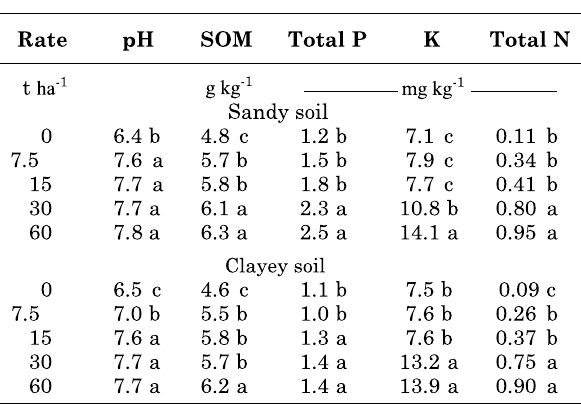
Table 2. Soil pH, soil organic matter, total P, total N and exchangeable K contents in the sandy and clayey soils after amendment with